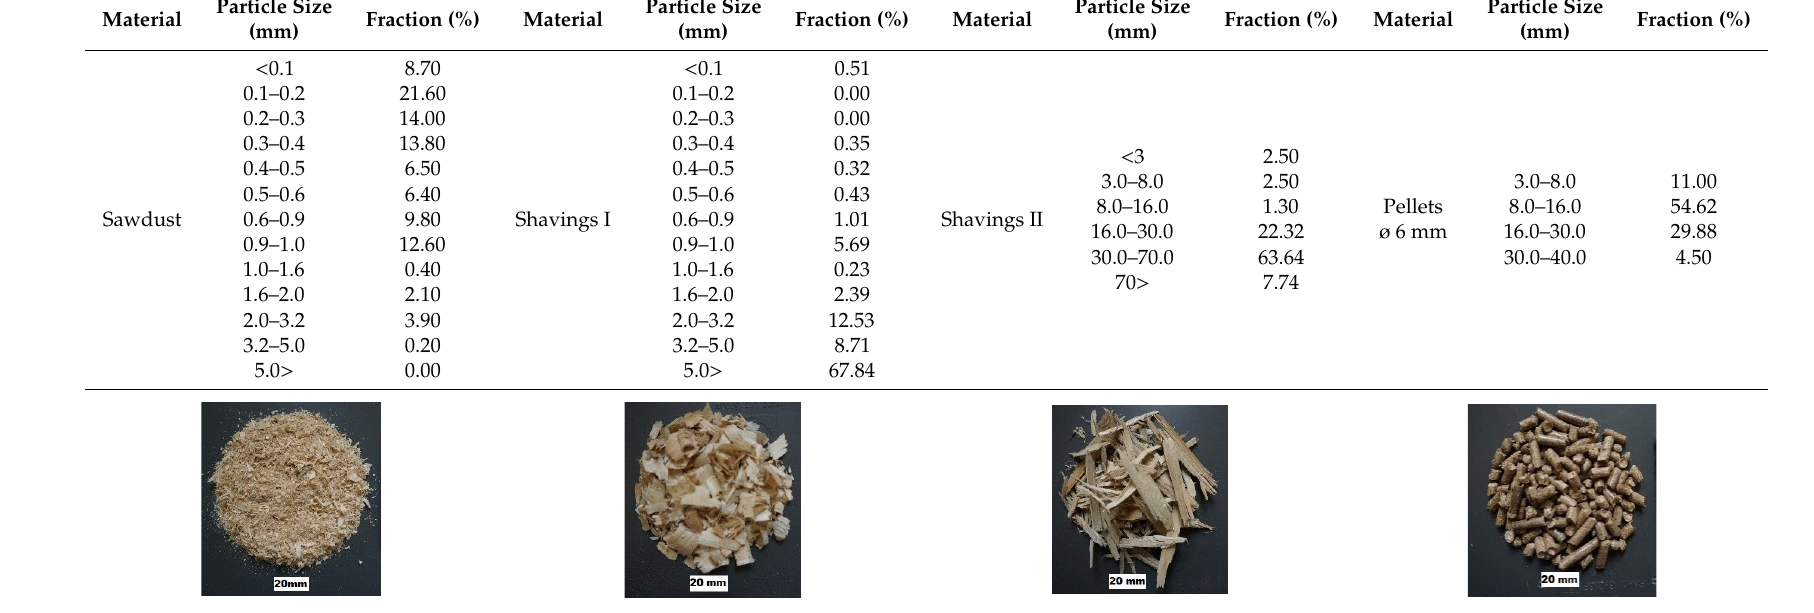
Table 1. Size distribution of the pine biomass materials (Stasiak et al.,